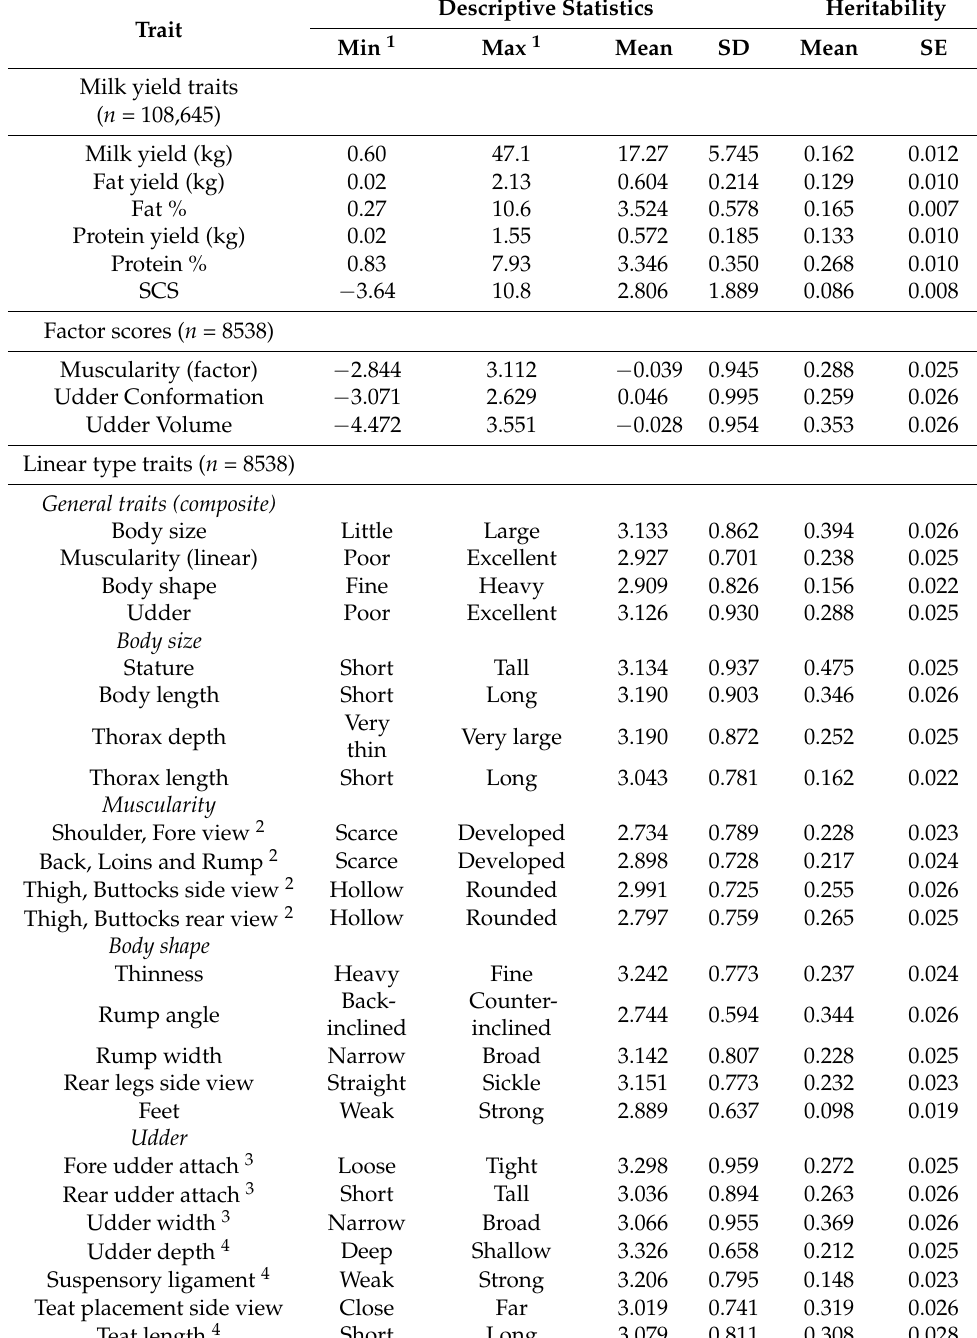
Table 1. Descriptive statistics (minimum and maximum, phenotypic mean, and standard deviation) for milk yield traits and linear type traits included in the study, and heritability obtained using the single trait animal models. Posterior mean (Mean) and standard error (SE) calculated for the variances obtained after running the Gibbs sampling algorithm are shown for heritability. The division of traits in categories (composite traits and four body regions is reported in